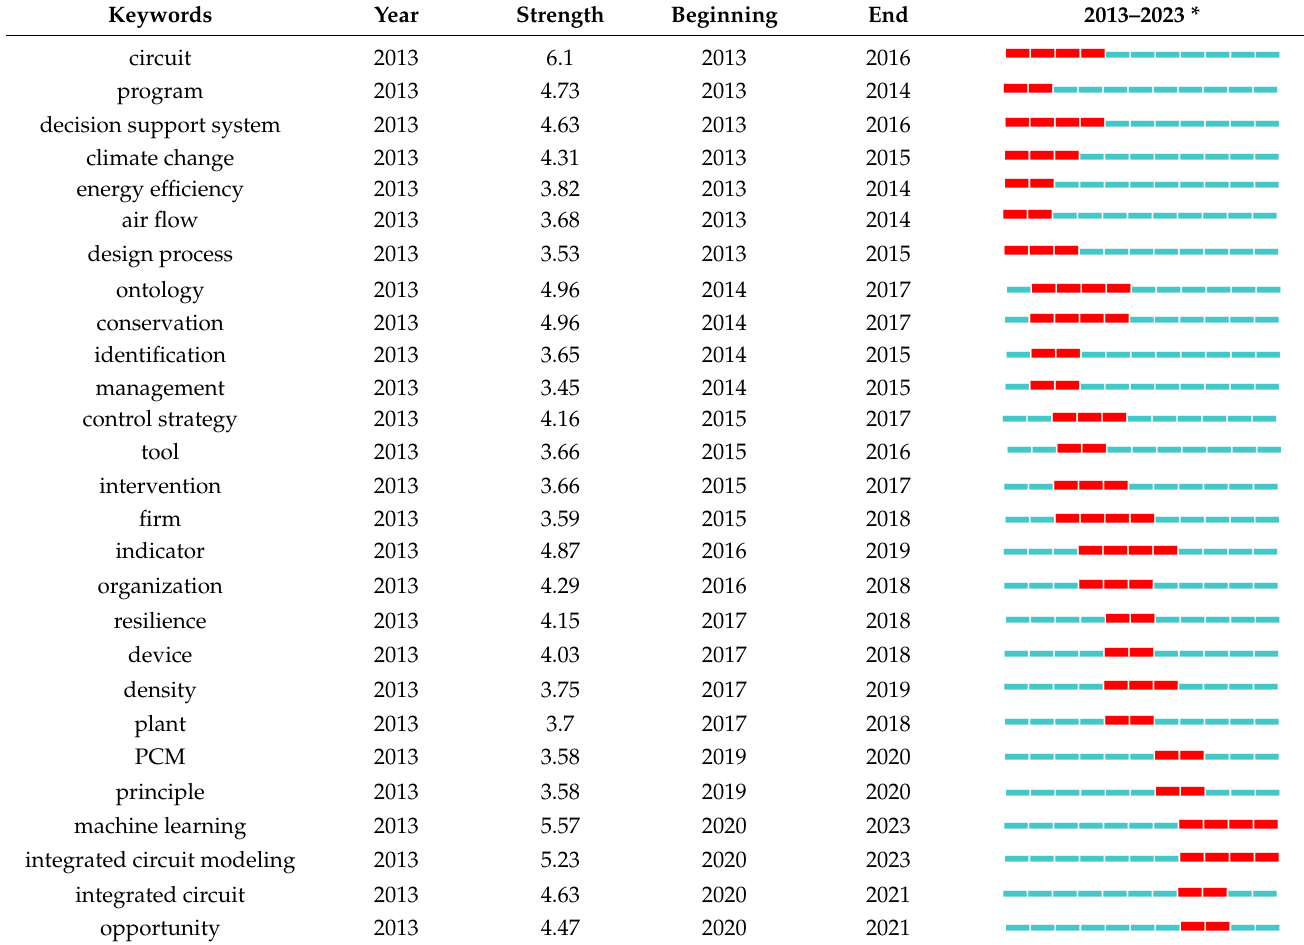
Figure 3. Analysis of keyword co-occurrence diagram of integrated building design process. In the study, based on the database, the mutation wor ds of “integrated building de- sign process” are analyzed to reveal the changes in research hotspots in the past 10 years, as shown in Table 3. Table 3. Analysis of mutation words in integrated building design process. 1. ▃▃▃▃▂▂▂▂▂▂▂